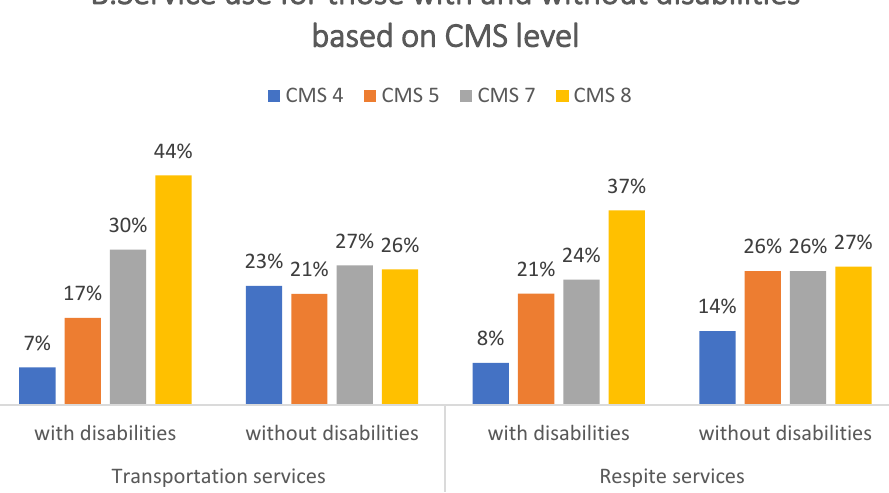
Figure 2. ( A ) Percentages of overweight and obese participants by “personal and professional care” and “transportation” services used based on CMS level. ( B ) Percentages of participants with and without disabilities by “transportation” and “respite” services used based on CMS level.